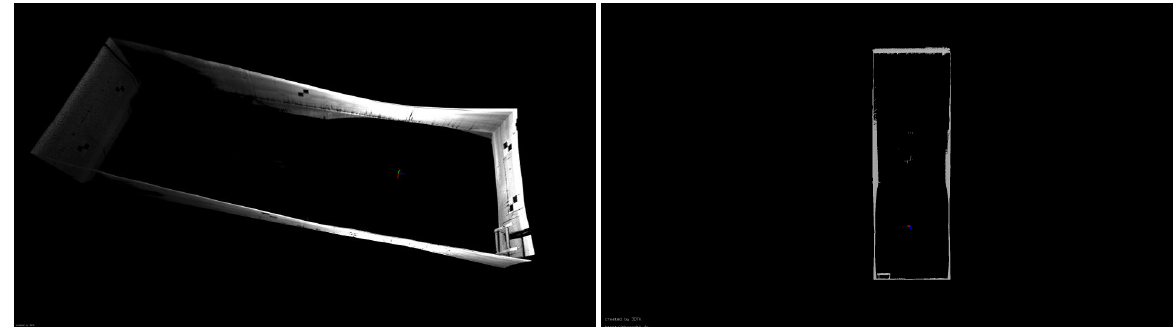
Figure 9. One of the first scans with our 3D laser line scanner in the test environment. On the right site is an top view to the point cloud.